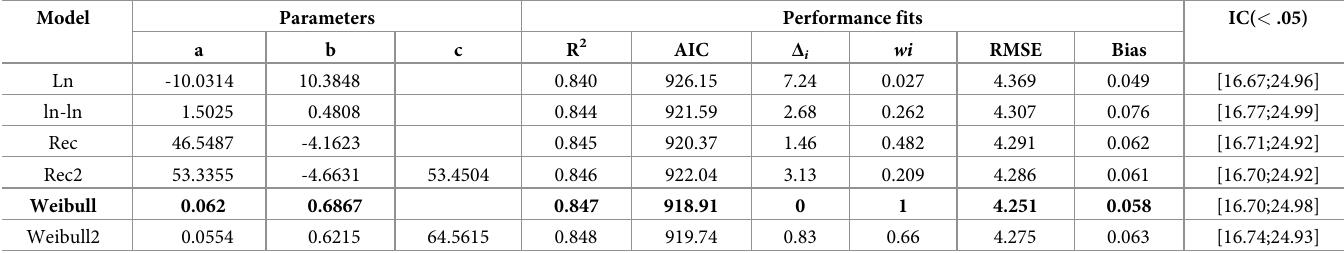
The values in bold show the best model. R 2 is the correlation coefficient, AIC is the Akaike Information Criterion, Δ i is the difference in AIC between each model